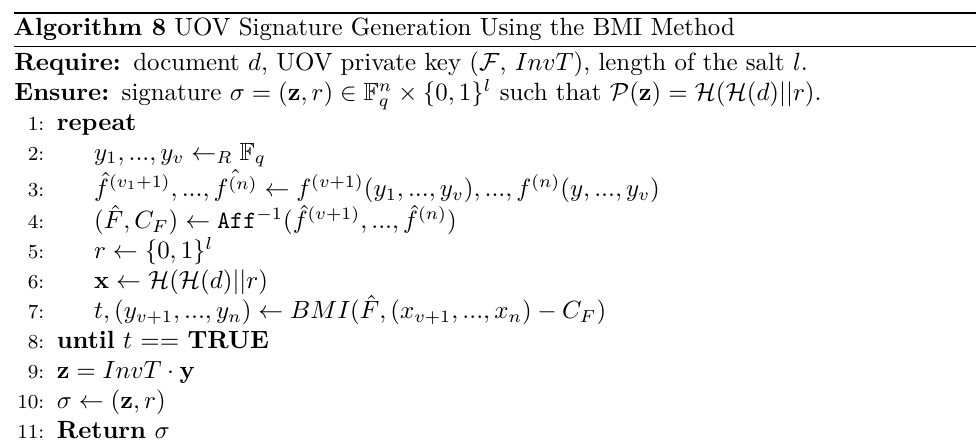
Algorithm 8 UOV Signature Generation Using the BMI